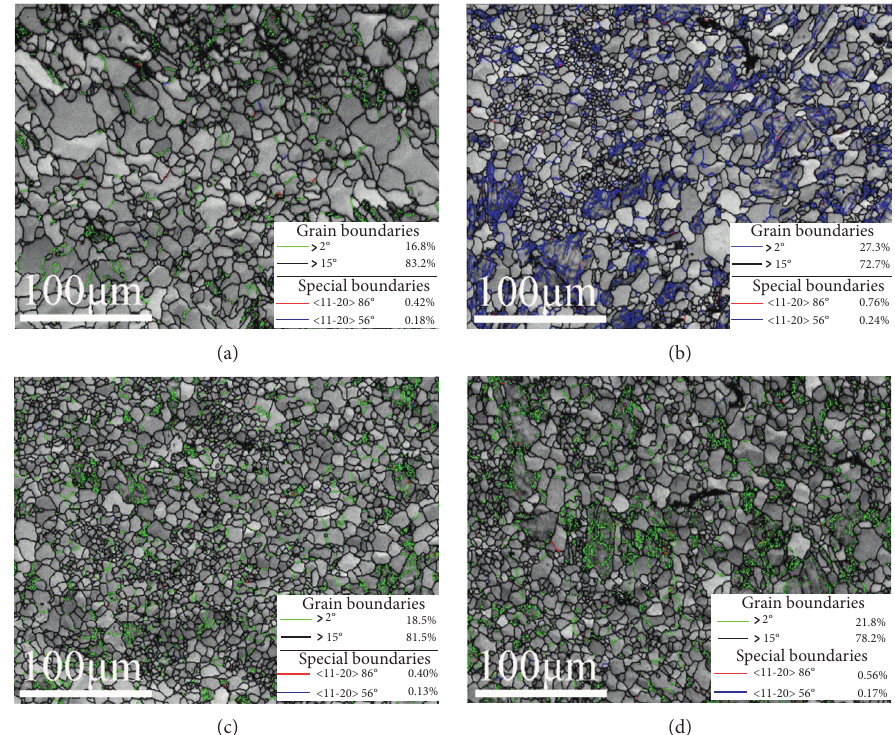
Figure 7: Twins and high/low-angle boundary distribution diagrams of the as-rolled Mg-6Sn-3Al-1Zn alloys at different rolling tem- peratures: (a) 300 ° C, (b) 350 ° C, (c) 400 ° C, and (d) 450 °